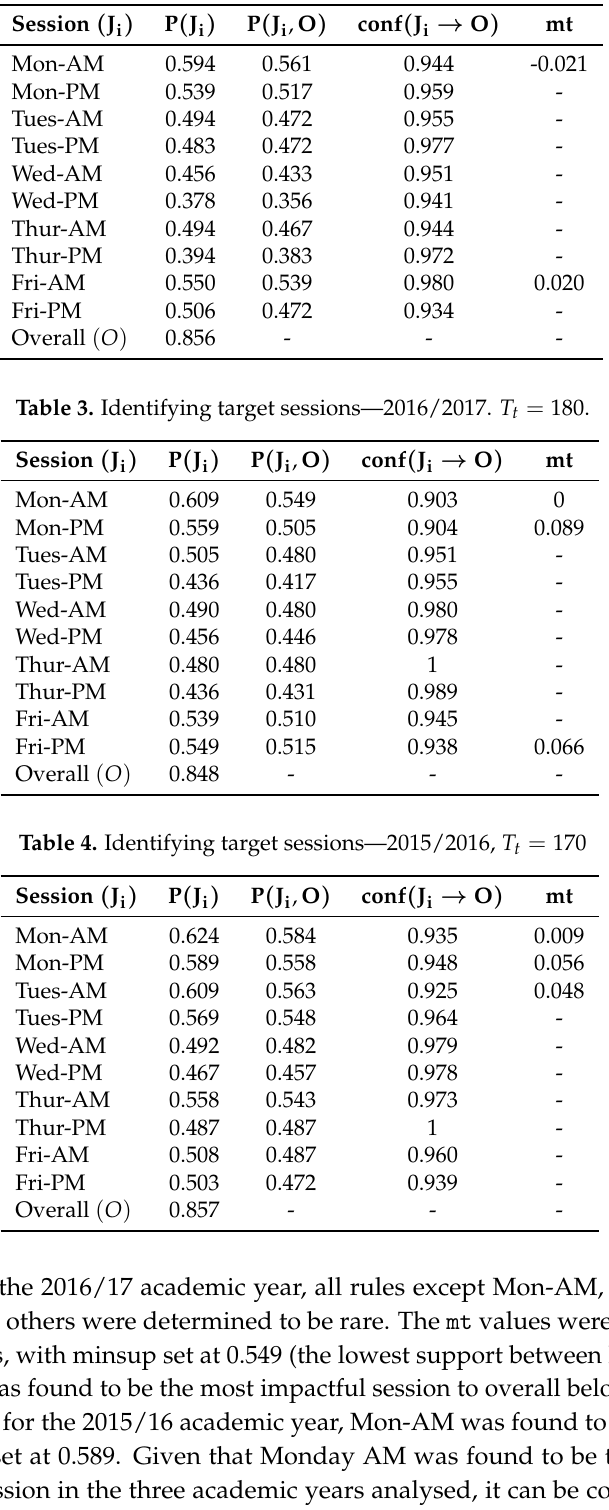
Table 2. Identifying target sessions—2017/2018, T t = 179.